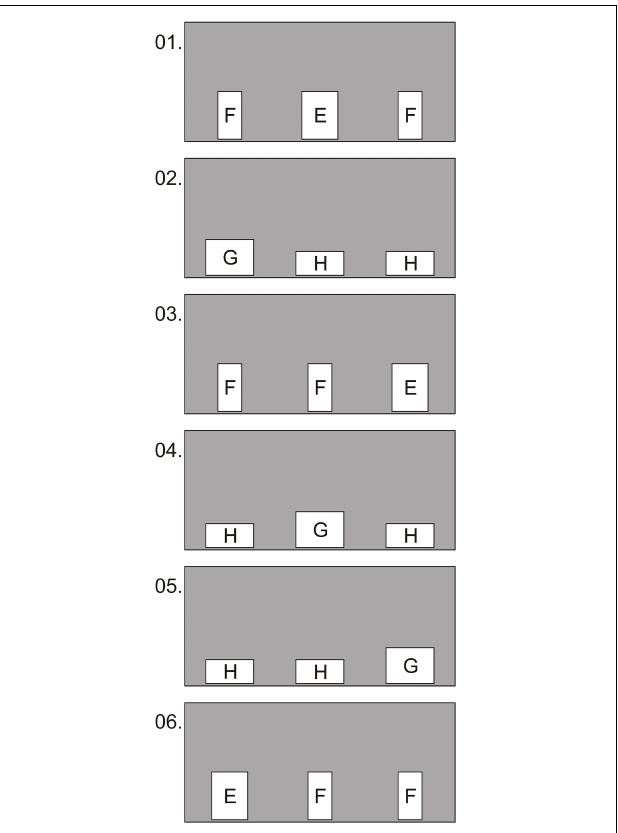
FIGURE 4 | Experiment 1, group 2, test: examples of the first 6 conditions in which the holes were oriented with the long side either vertically (conditions 1, 3, 6) or horizontally (conditions 2, 4, 5). Hole sizes: E—15 × 20 cm; F—10 × 20 cm; G—20 × 15 cm; H—20 × 10 cm.